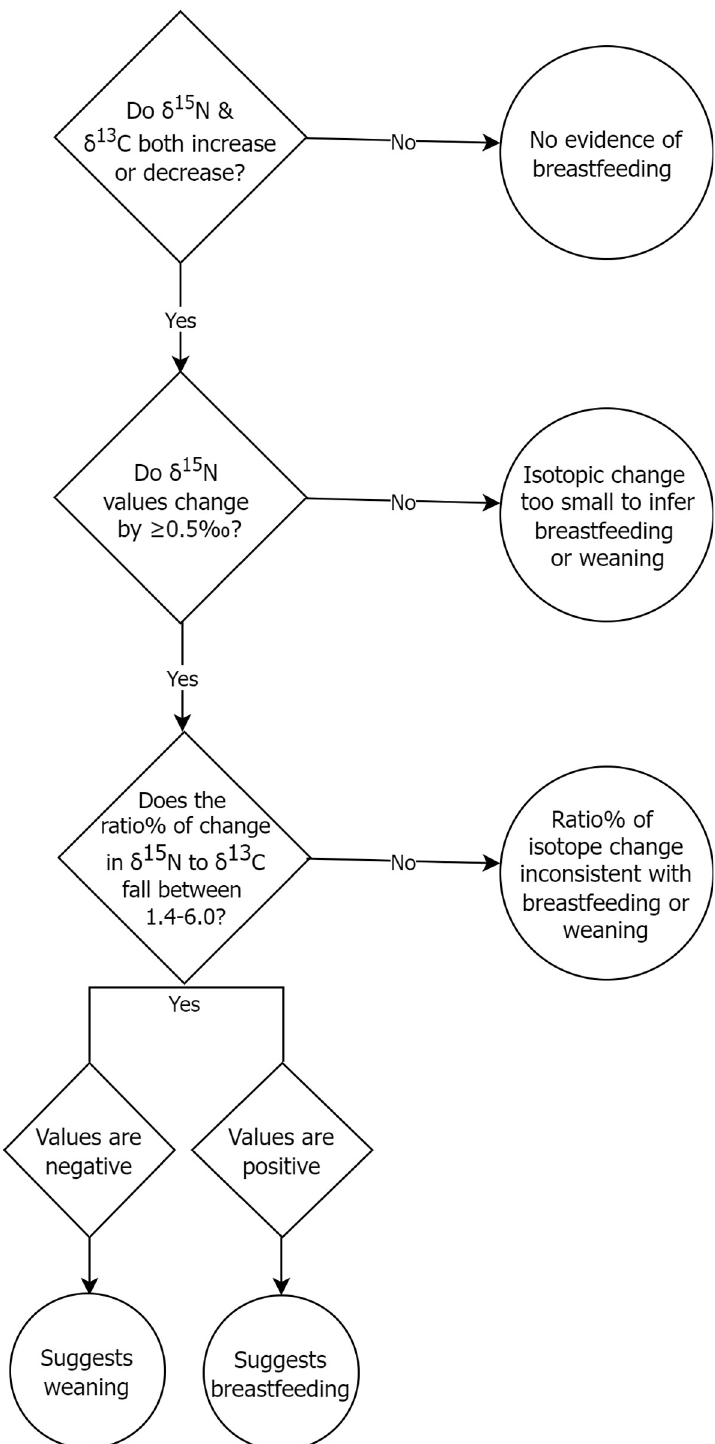
Fig 3. Interpretive method 2 decision tree for categorizing infant feeding status at death from covariation of δ 15 N and δ 13 C values.